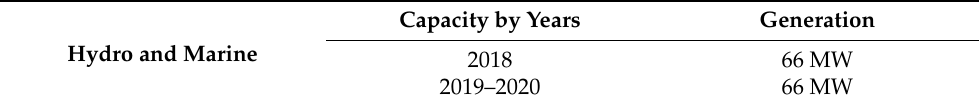
Table 10. Tunisian electricity capacity by hydropower [18].